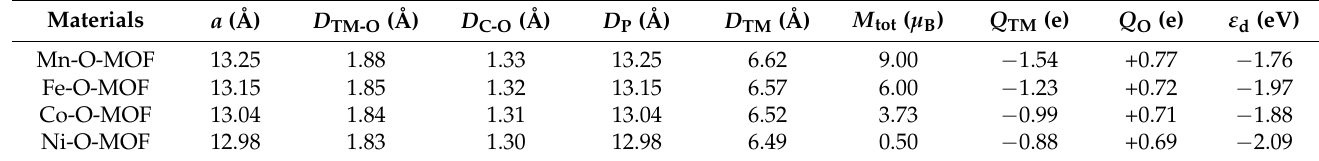
Figure 1. The representative ( a ) top and ( b ) side views of TM-O-MOF single-layer structure. Table 1. Calculated geometric parameters including the lattice constants ( a ), the bond length of TM-O ( D TM-O ), C-O ( D C-O ), the pore size ( D P ), the distance between the metal atoms ( D TM )], total magnetic moment ( M tot ), Bader charge [ Q TM , Q O ], and d -band center ( ε d ) of TM-O-MOF single-layer structures.